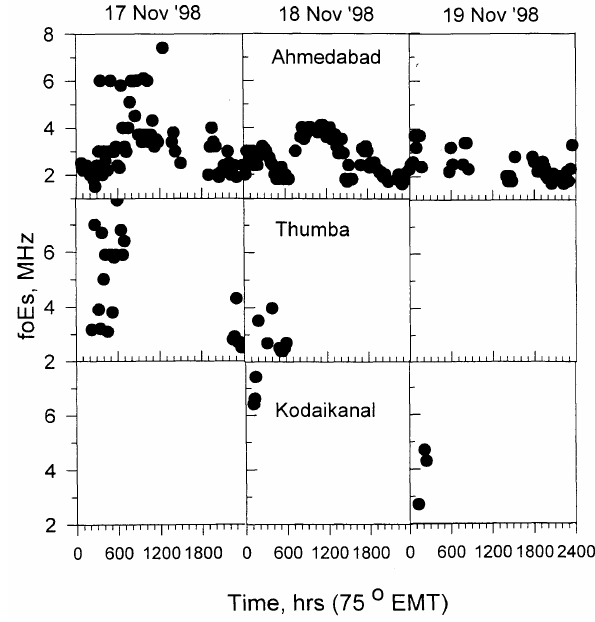
Fig. 10. Daily variations of f 0 E s over Ahmedabad, Thumba and Kodaikanal for the period 17–19 November 1998 based on quarter hourly